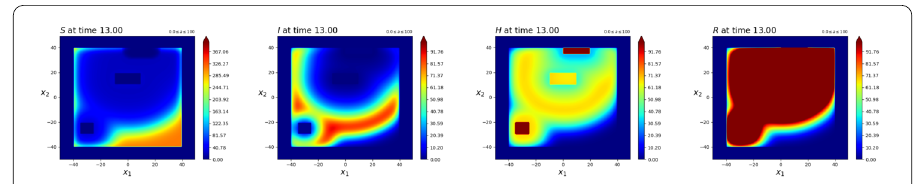
Figure 12 Contour plots of the solution to the “CareHomes” integration at time t = 13. The front of the pandemic for the I population spreads from the care house C 2 , as defined in (12)